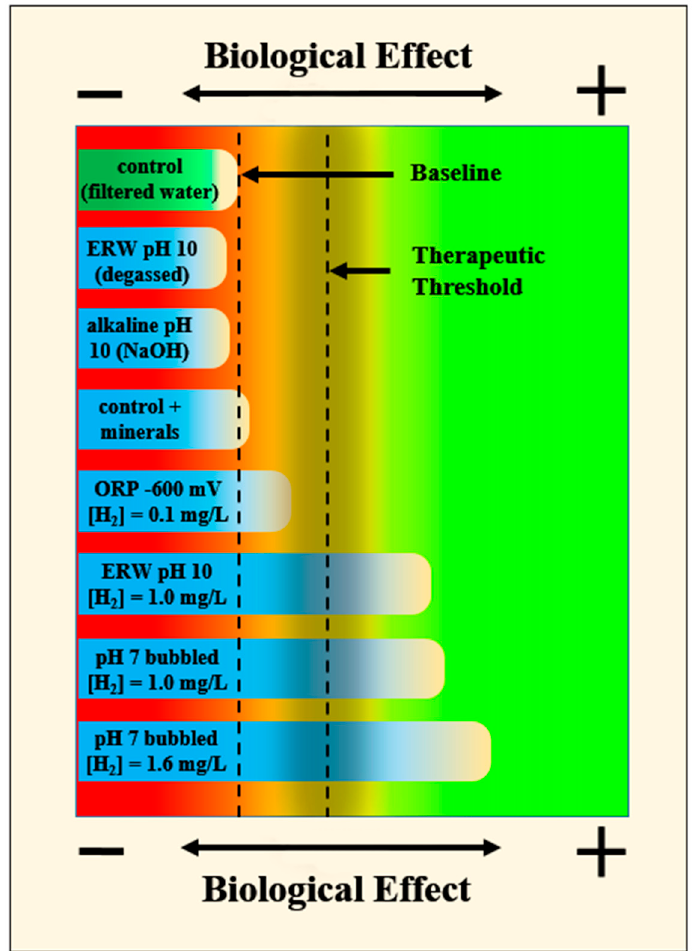
Figure 2. A hypothetical symbolic representation of relative benefits from various water conditions. ERW or NaOH pH 10 water provides no benefit compared to baseline with a downward trend. A negative ORP from the presence of a low level of H 2 exerts only a positive beneficial trend. However, at higher H 2 concentrations in ERW or with bubbled H 2 , the therapeutic threshold is passed, and there is a dose-dependent H 2 benefit.